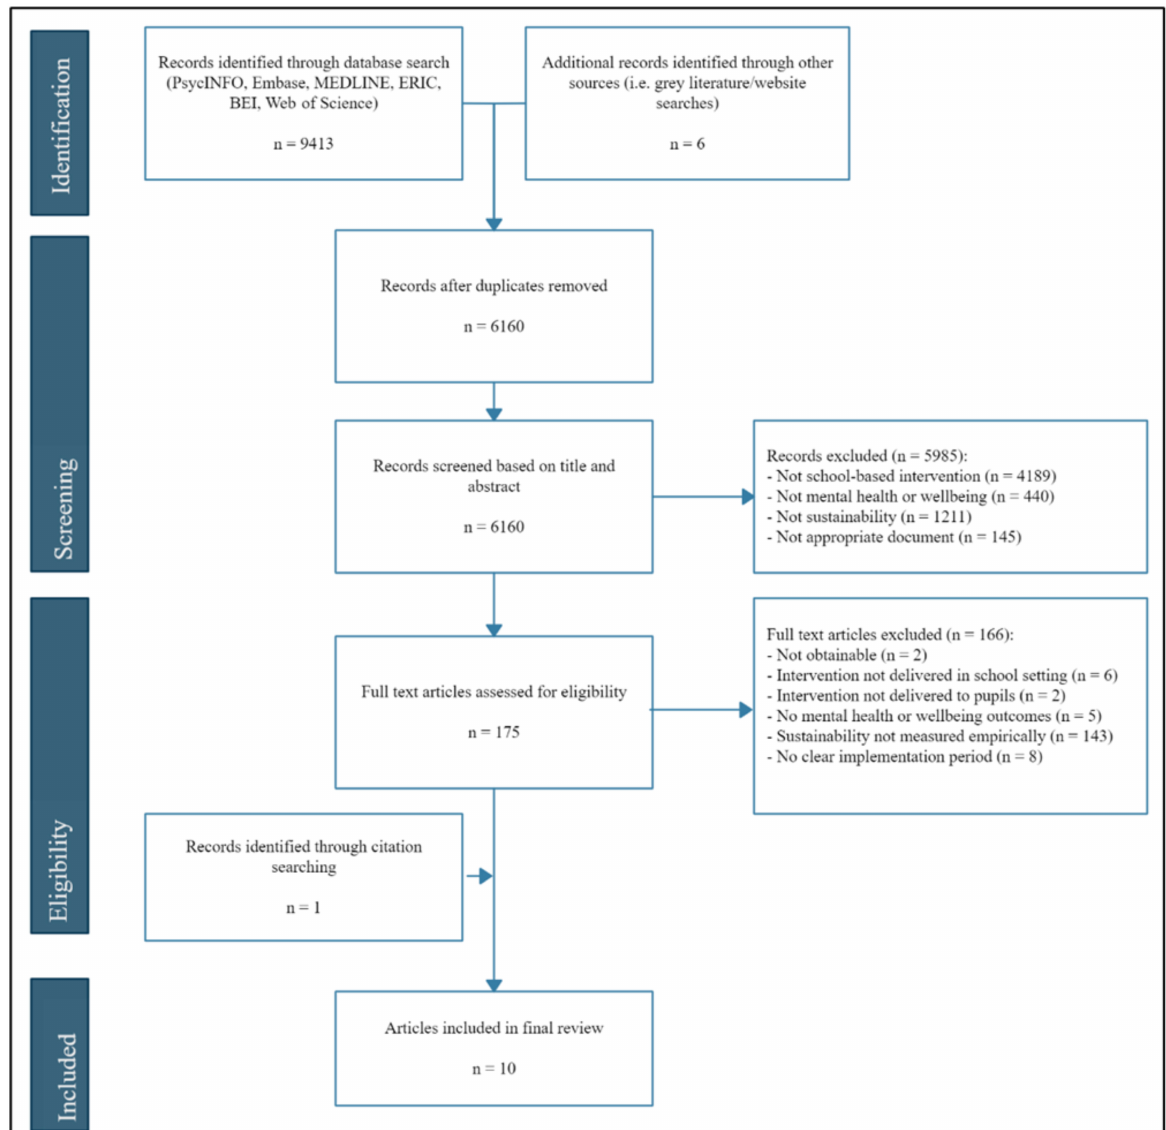
Figure 1. PRISMA flow diagram of the study selection